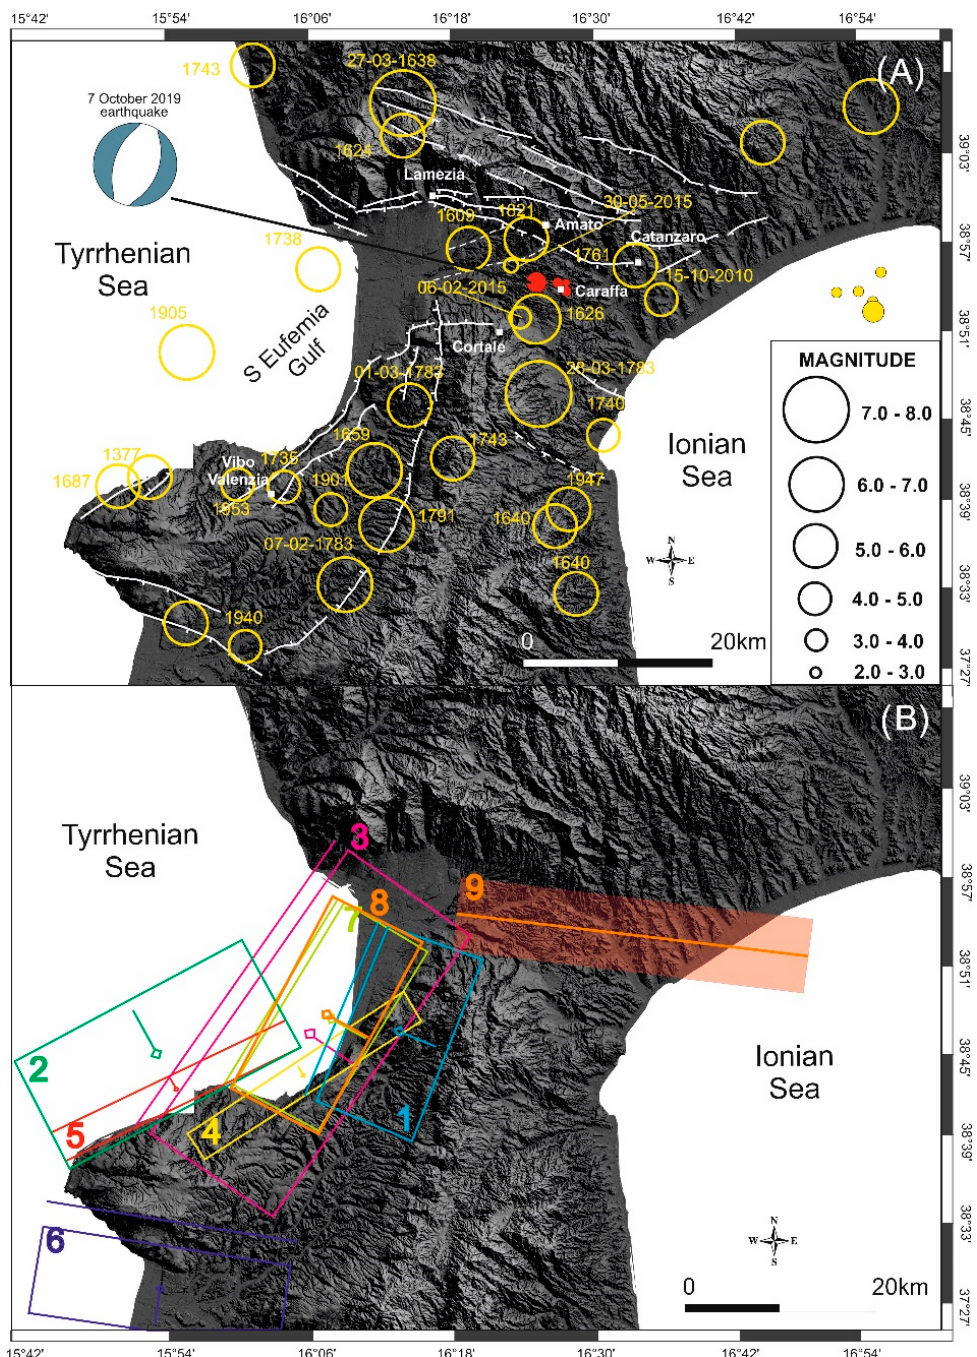
Figure 2. ( A ) Historical and instrumental seismicity of the investigated area (see Figure 1A for location), with magnitude higher than 4.8 (CPTI, [16]); the 2017 and 2019 seismic sequence are reported though they have magnitude lower than 4.8: filled yellow circles are the seismic sequence that occurred in July 2017; filled red circles are the seismic sequence of October 2019; focal solution refers to the 7 October 2019 earthquake; white lines with barbs are normal faults, white lines with arrows are strike slip faults; ( B ) Seismogenic sources of the 1905 earthquake from the literature (see also [29]): (1) Angitola Fault [30]; (2) Capo Vaticano Fault [10]; (3) Angitola Fault [31]; (4) Vibo Valentia Fault [32]; (5) Capo Vaticano Fault [32]; (6) Coccorino Fault [33,34]; (7) Santa Eufemia Fault [29], (8) Santa Eufemia Individual Seismogenic Source [35]; (9) Caraffa ‐ Squillace Gulf composite seismogenic source [35].